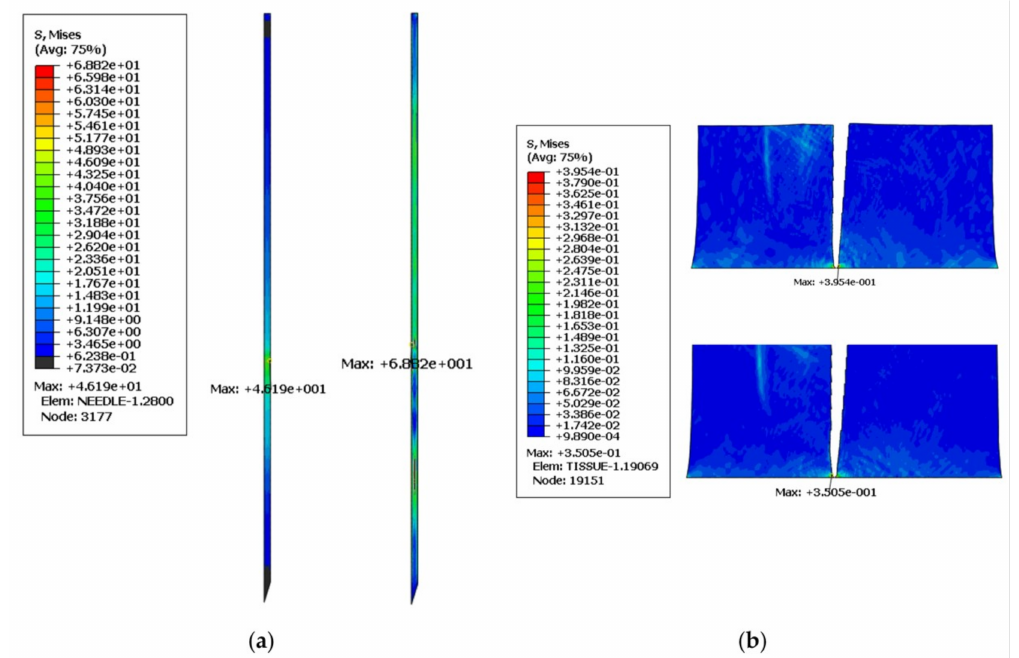
Figure 13. von Mises stress contours: ( a ) the maximum force on the needle at the same time point (coated needle, left, uncoated needle, right); ( b ) maximum force on the tissue at the same time point (coated needle, down, uncoated needle,